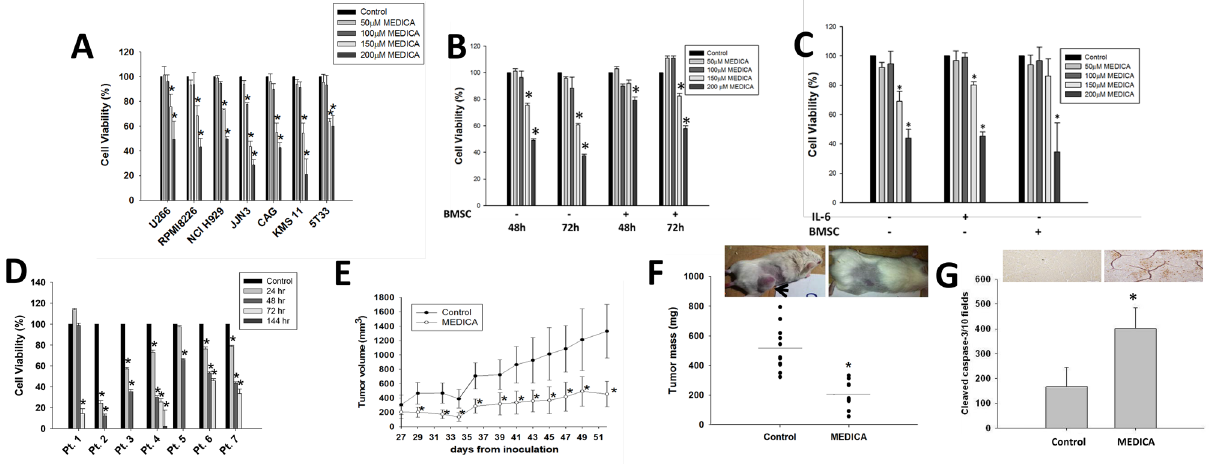
Figure 1. Suppression of MM cell proliferation by MEDICA. (A) Cell viability of MM cells cultured for 48 h with MEDICA as indicated. Mean ± SD of 5–8 replicates of 3–5 independent experiments. *Significant as compared with nontreated (p < 0.05). ( B) Cell viability of U266 MM cells cultured with MEDICA in the presence or absence of BMSC as indicated. Mean ± SD of 5–8 replicates of 3 independent